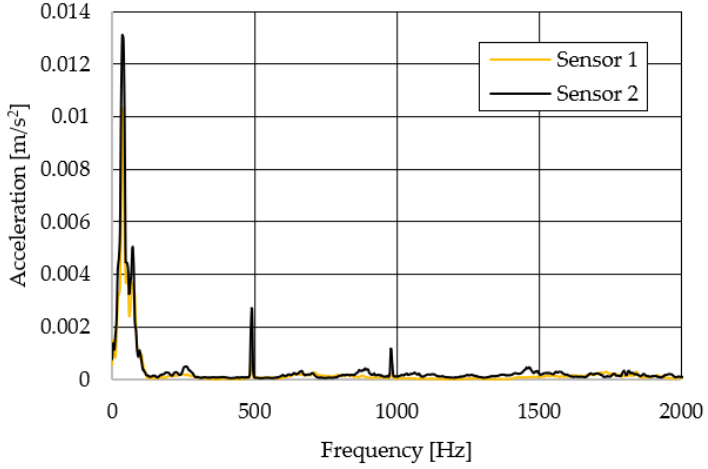
Figure 24. Comparison of the frequency waveforms in the y -axis during asymmetrical crossing over